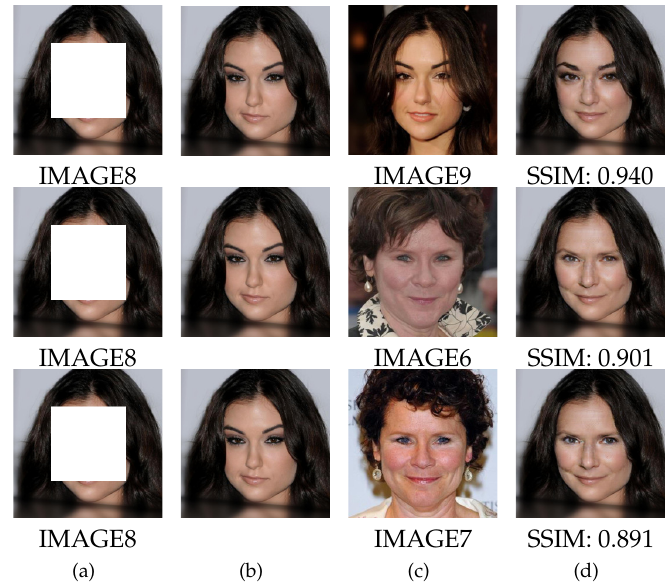
Figure 10. The completion results of a masked IMAGE8 using different reference face images: ( a ) masked input; ( b ) ground-truth; ( c ) reference face images; ( d ) results of